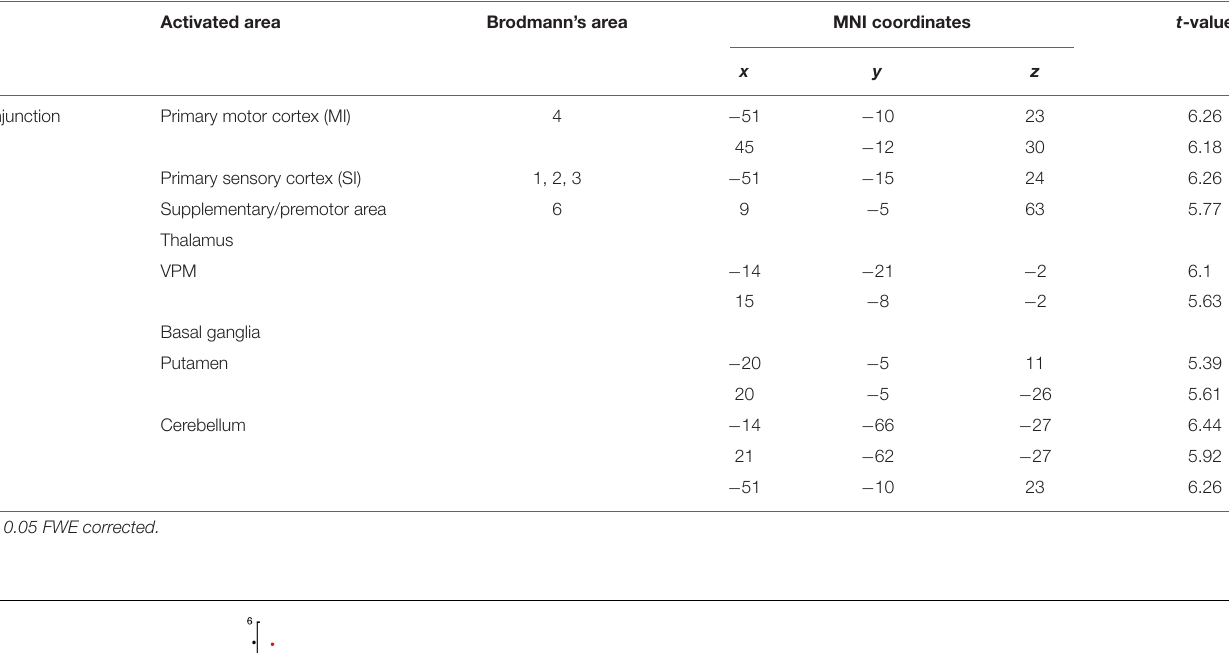
TABLE 3 | Significantly activated regions during tapping (conjunction analysis).